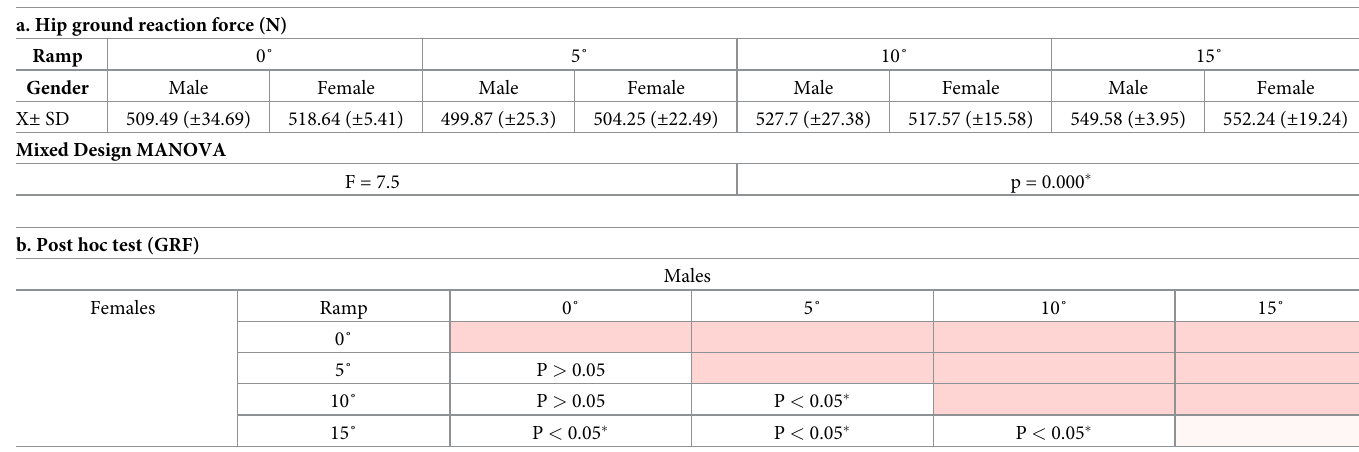
Table 4. The tables indicate (a) the interaction between the ramps and the gender on the mean value of the resultant total ground reaction force at the mid stance phase of the gait cycle while walking up ramps. (b) the post hoc test carried out on male and female subject’s categories and is based on the hip ground reaction force cal- culated for different ramp elevations as in Table